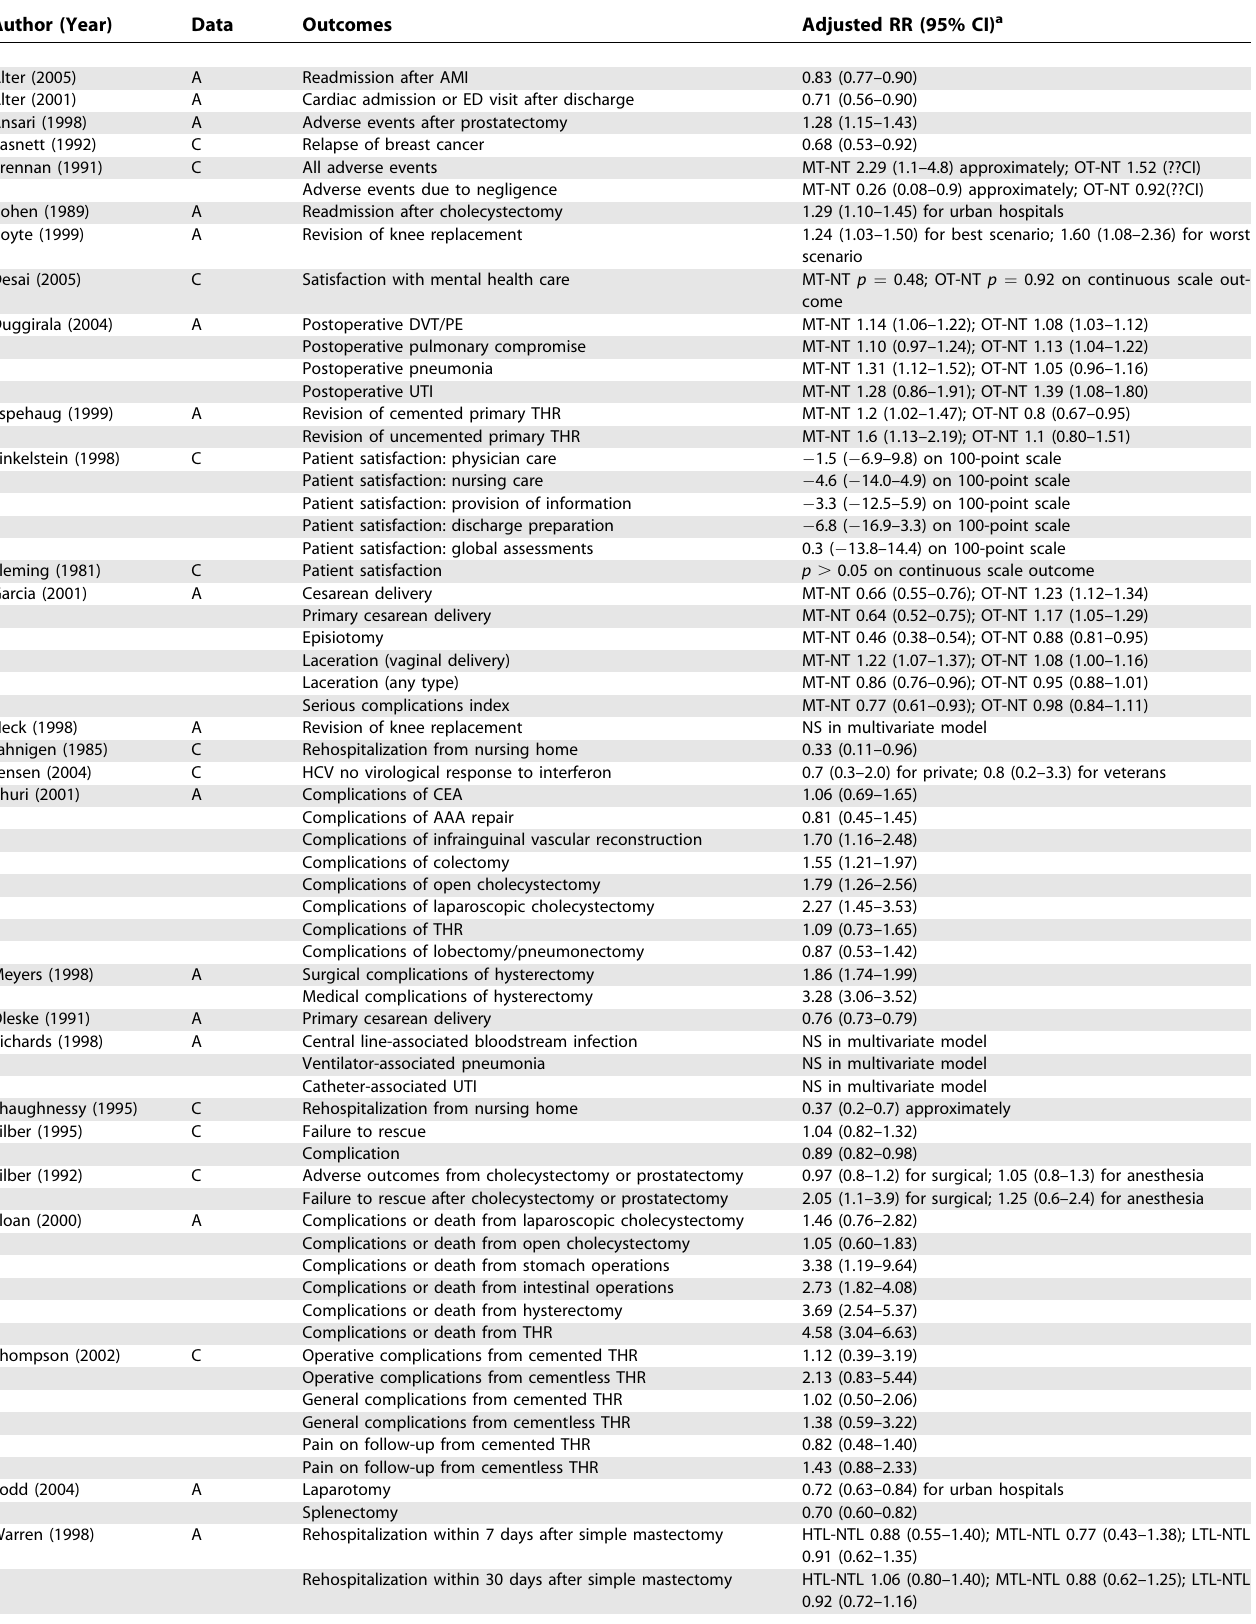
Table 3. Comparisons of Teaching versus Nonteaching Healthcare on Other Patient Outcomes Besides Mortality Author